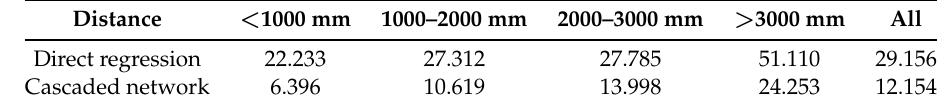
Table 5. The mean error on z-axis with respect to the distance from hand to camera. (The unit of the values in table is mm.)